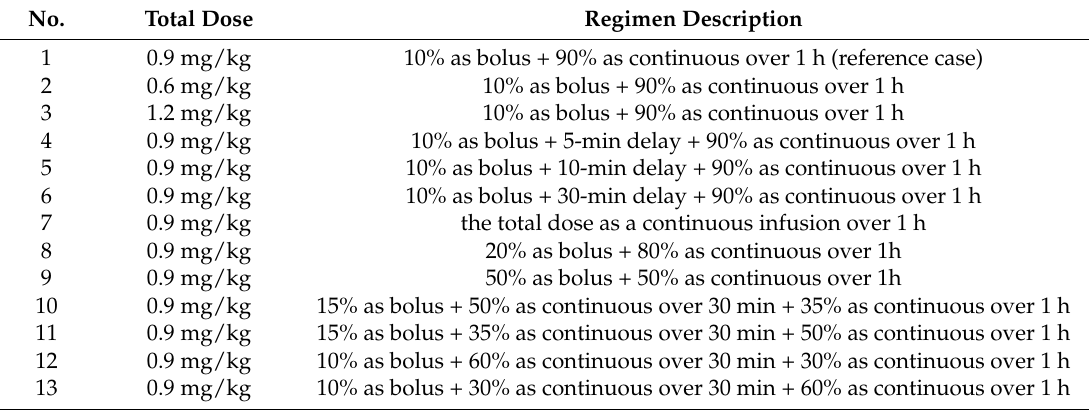
Table 2. List of simulated dosage regimens. Regimen 1 is the standard dose for the treatment of ischaemic stroke.